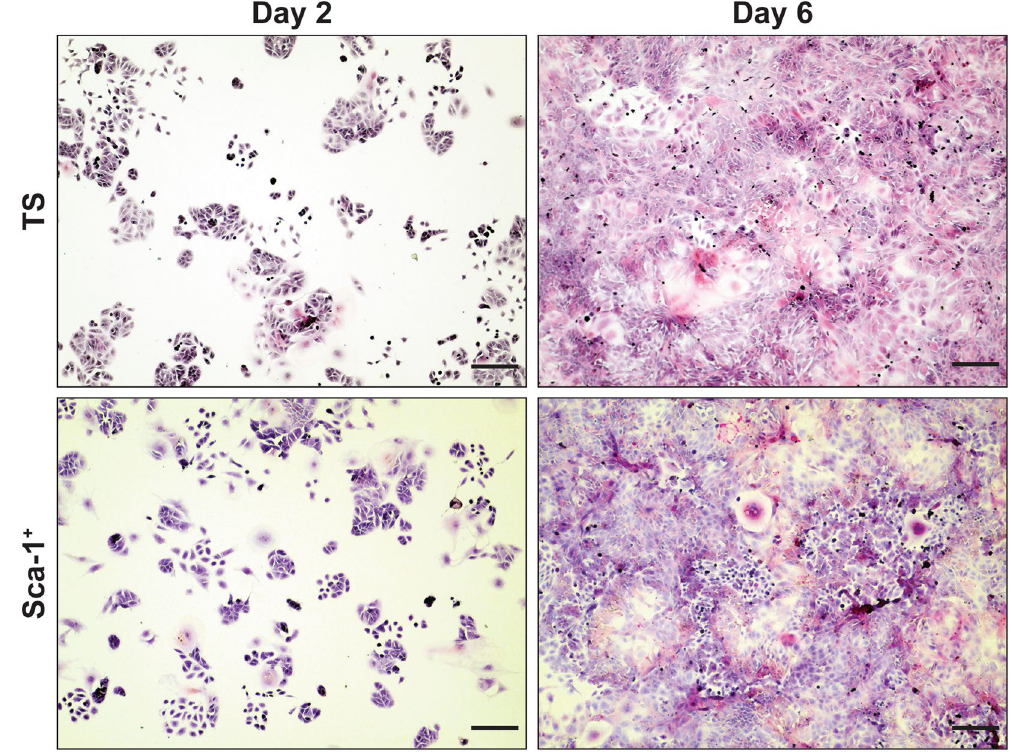
Figure 3. Sca-1 + trophoblast isolated from differentiated TS cell cultures and re-plated in TS media plus growth factors formed colonies comparable to TS cells plated at the same density from proliferating cultures (compare TS and Sca-1 + , Day 2). After six days of culture in TS media plus growth factors, both Sca-1 + and TS cells were confluent and appeared similar in morphology (compare TS and Sca-1 + , Day 6). Cells were stained with hematoxylin and eosin. Scale bar = 500